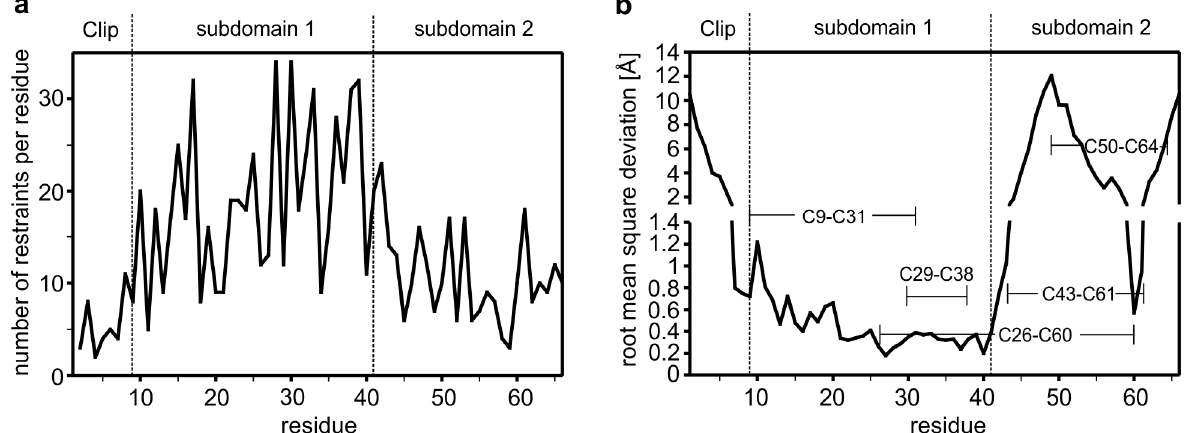
Figure 1. ( a ) Number of NOE-derived distance restraints per residue showing a rather low number of experimental restraints. ( b ) Root mean square deviation (r.m.s.d.) for the backbone atoms derived from a structure alignment of 10 selected structures to the average structure. Structural superposition was performed on the backbone atoms of Glu10 to Glu41). The tripartite architecture comprising the Clip segment and subdomains 1 and 2 are indicated, the disulfide bond connectivity is